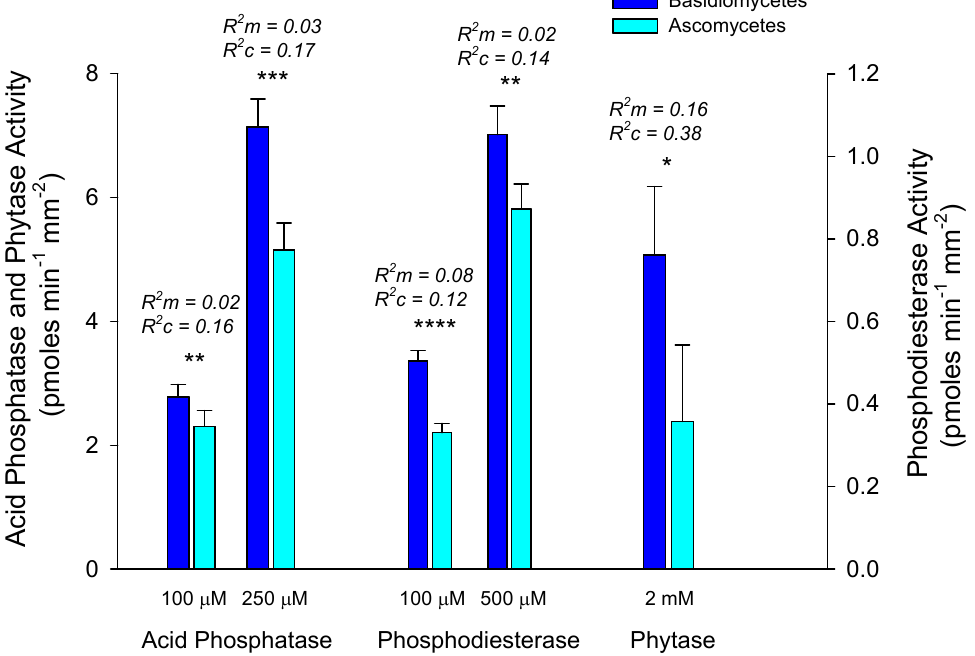
Figure 3. Comparison of mean ± S.E. activities of acid phosphatase, phosphodiesterase and phytase of alder root tips dominated by Ascomycete versus Basidiomycete ectomycorrhizal fungi (EMF) averaged across all horizons and stages. Significant di ff erences between phylum are indicated above bars at p < 0.10 (*), 0.05 (**), 0.01 (***), and 0.001 (****). Marginal ( R 2 m ) and conditional ( R 2 c ) values generated for linear mixed e ff ects models evaluate variance explained by fixed and fixed + random e ff ects, respectively (see Statistics section